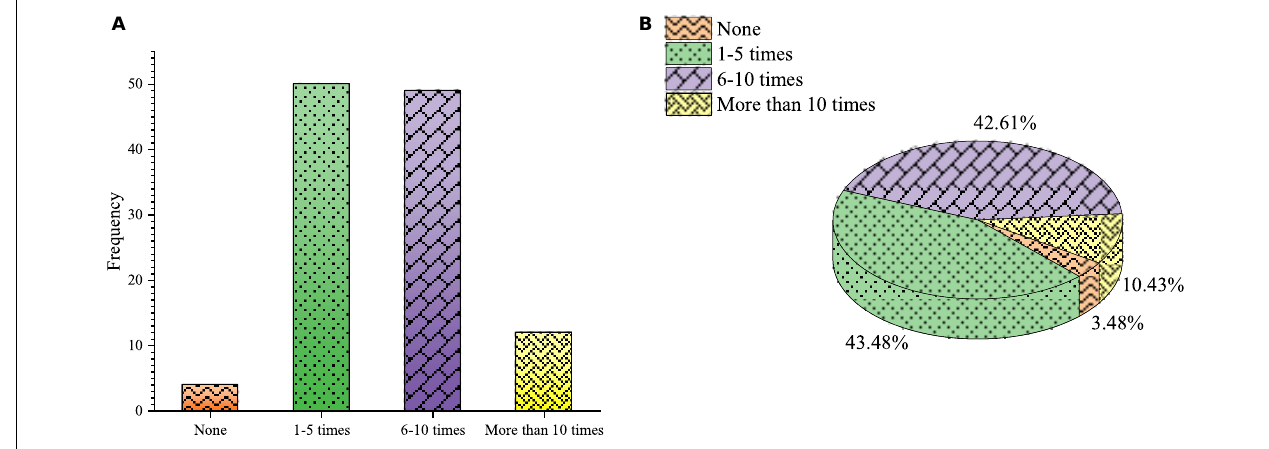
FIGURE 8 | Entrepreneurship education-related activities opened by the university (A) frequency (B) percentage.